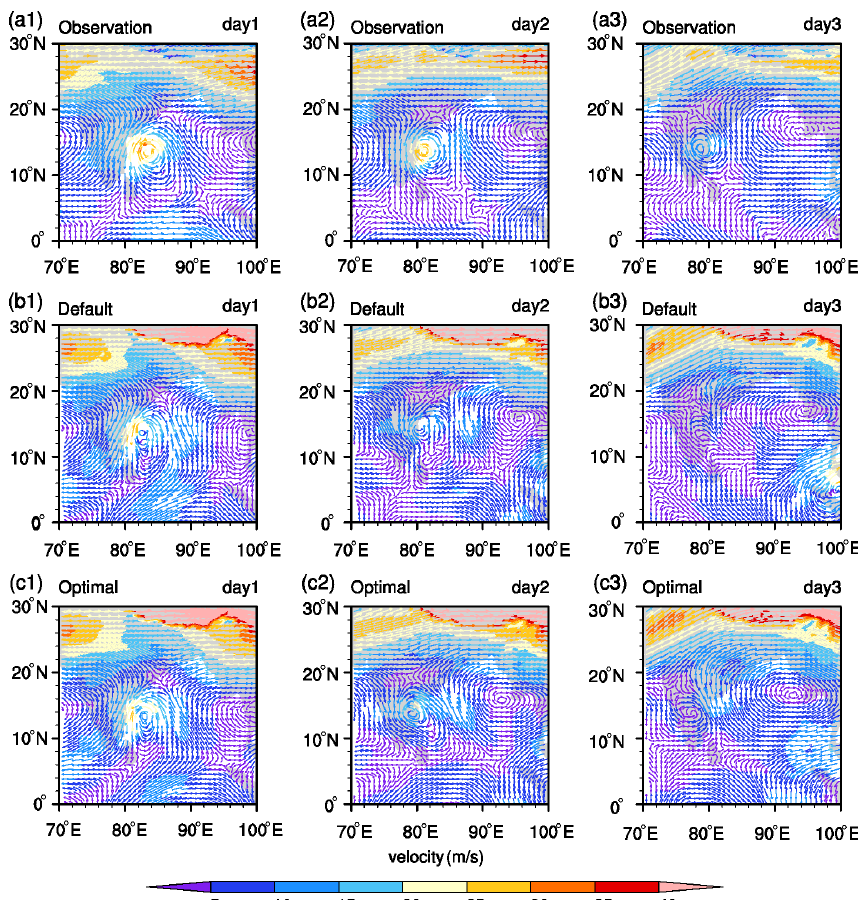
Figure 16. The wind velocity field at 500hPa for the simulation of VSCS Thane using default and optimal parameters, compared with the observations. Panels (a1) to (a3) show observations at the end of day 1, day 2, and day 3; panels (b1) to (b3) show the simulations with default parameters; and panels (c1) to (c3) show the simulations with optimal